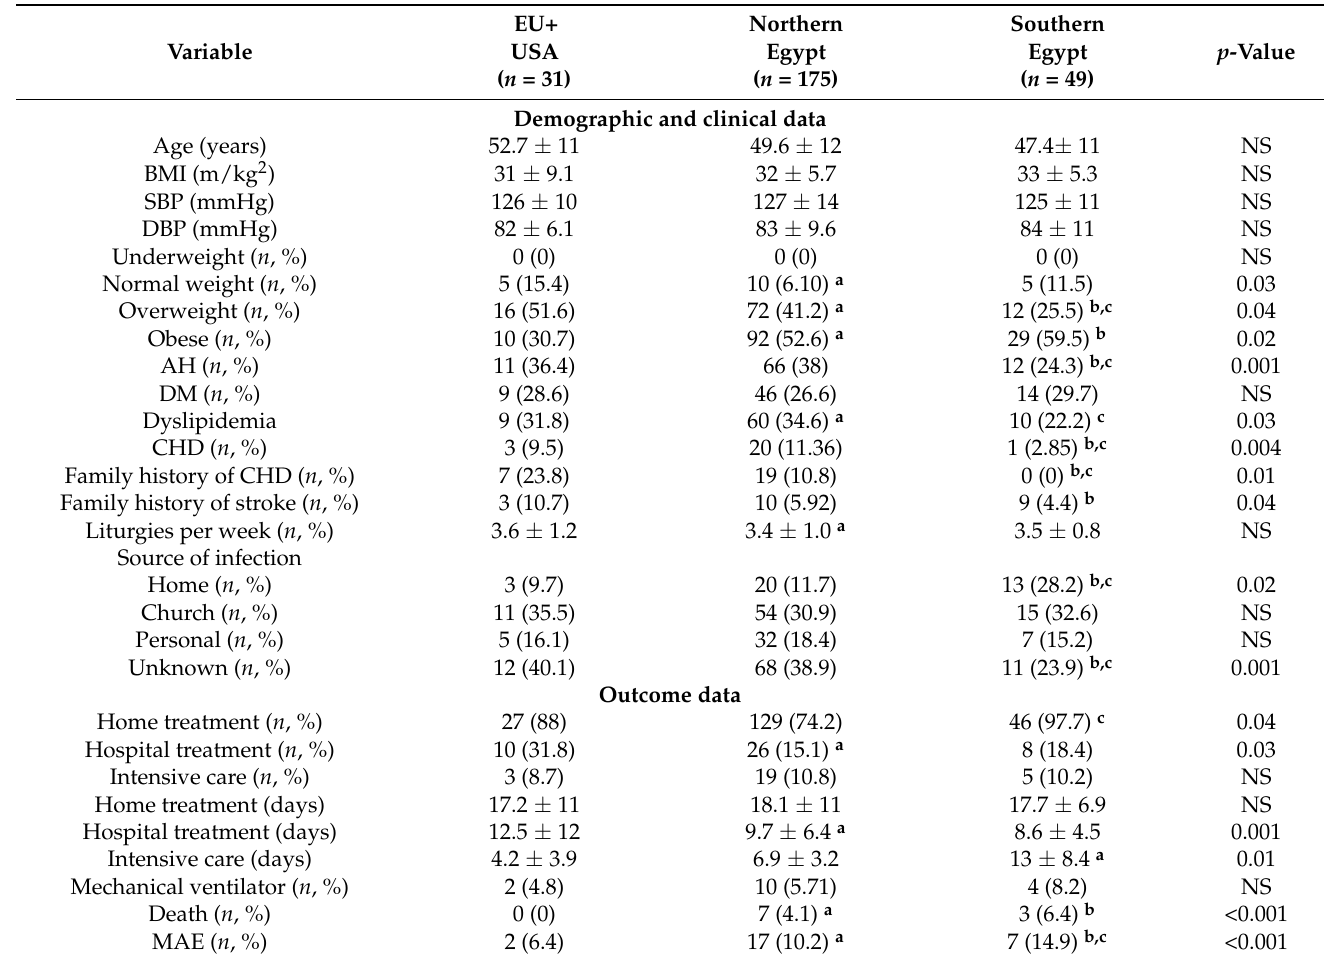
Table 3. Demographic, clinical and outcome data of priests in different